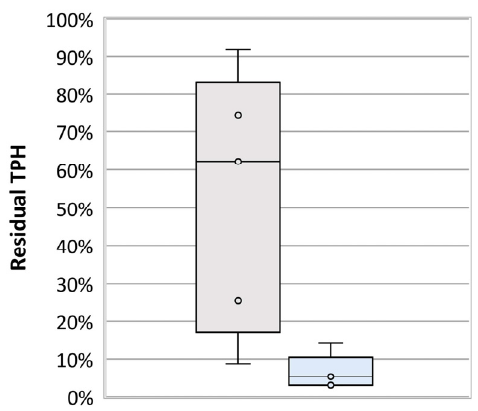
Figure 3. Residual TPHs at the end of the phytoremediation test with Helichrysum microphyllum subsp. tyrrhenicum in the refinery substrate with aged contamination unamended (UNAM, grey) and amended with wood chips (WCAM, blue). Residual TPHs were express as a percentage of the initial quantity for each experimental condition. Bars are drawn from each box to the higher and lower data within 1.5 times the interquartile range. Five pots for each experimental condition.